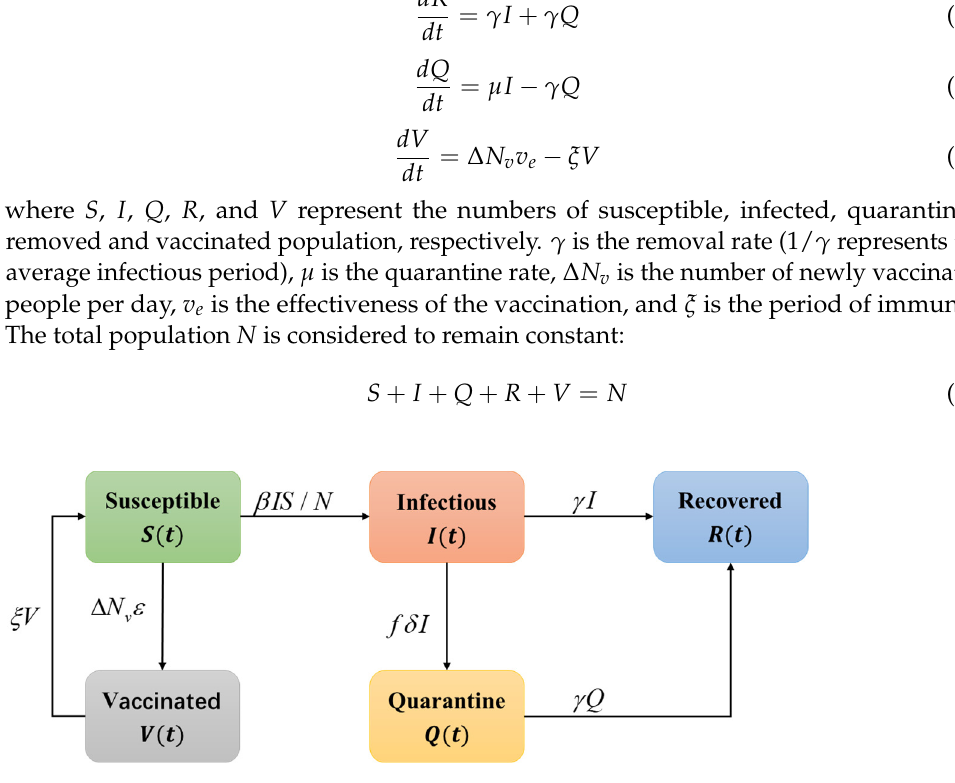
Figure 3. Generalized flow chart of SIQRV compartment model.